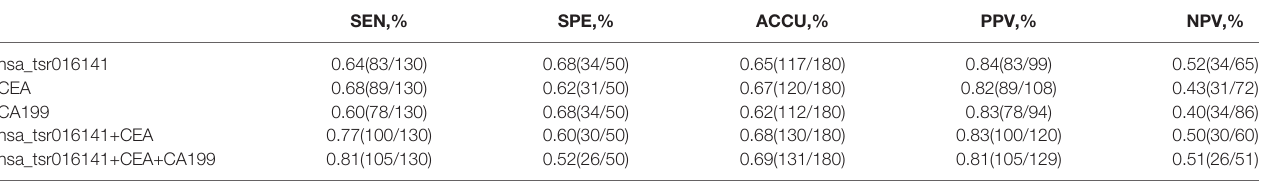
TABLE 3 | Use the expression levels of hsa_tsr016141, CEA, and CA199 to distinguish GC patients from gastritis patients.